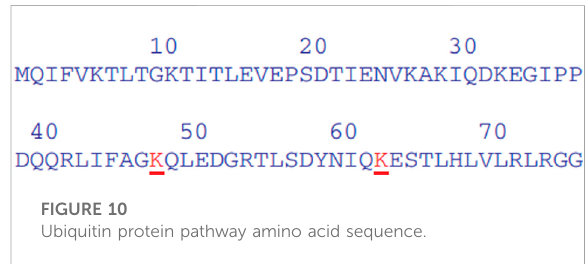
FIGURE 10 Ubiquitin protein pathway amino acid sequence.